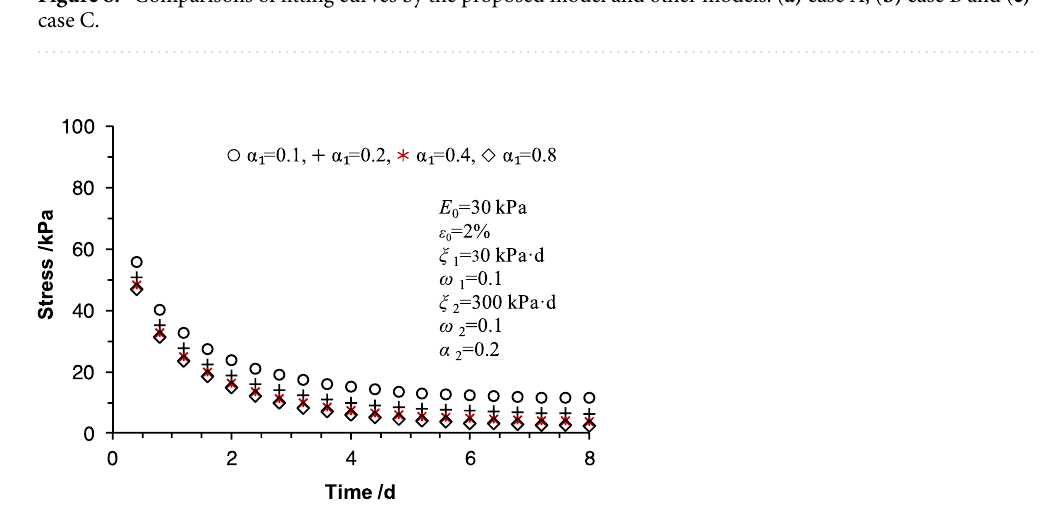
Figure 9. Sensitivity analysis of fractional order α 1